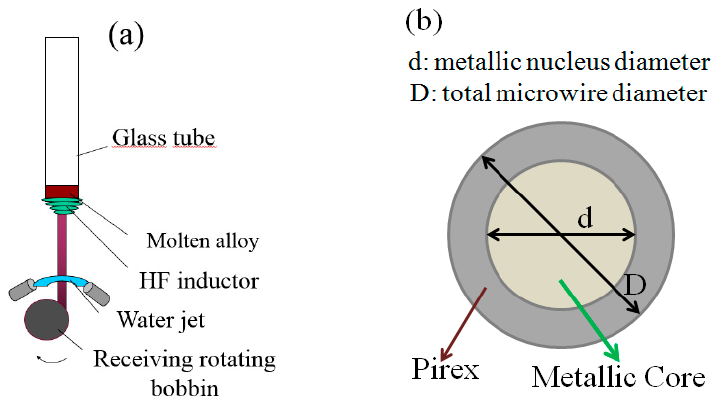
Figure 1. ( a ) Schematic picture of the fabrication process of glass-coated microwires. (Reproduced from reference [10], Figure 1), ( b ) cross section of a microwire.